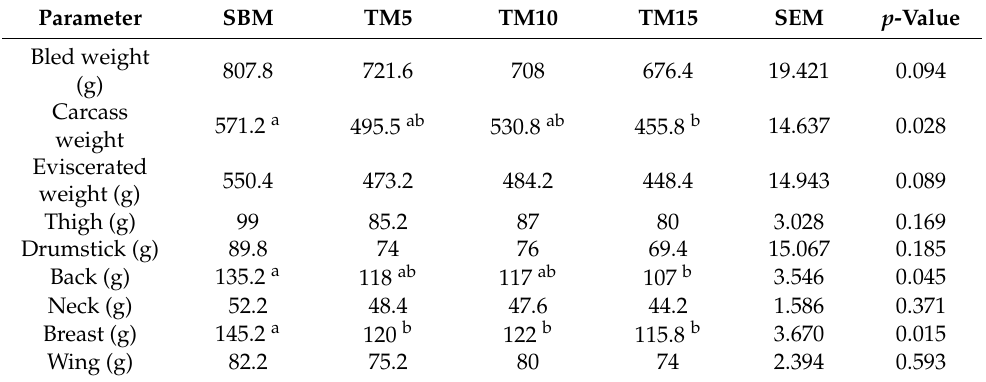
Table 2. Effects of yellow mealworm meal on carcass characteristics of Boschveld indigenous